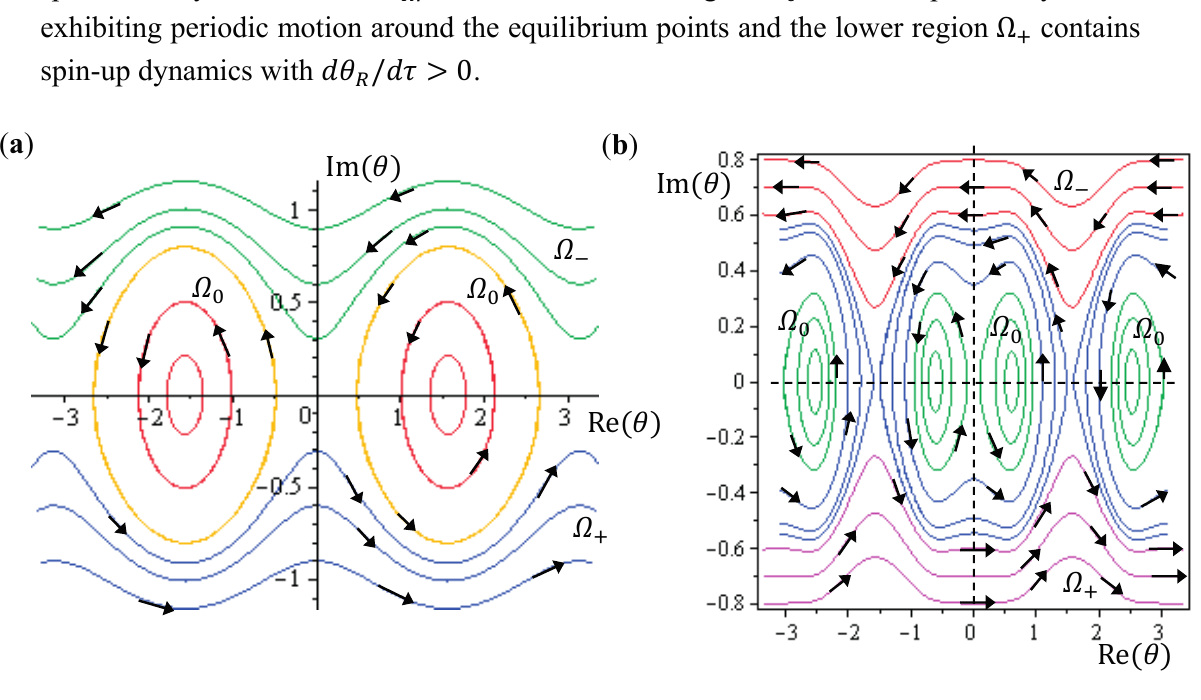
= 0 (cid:3011) contains (cid:2879) contains spinless dynamics (cid:2868) contains (cid:2878)